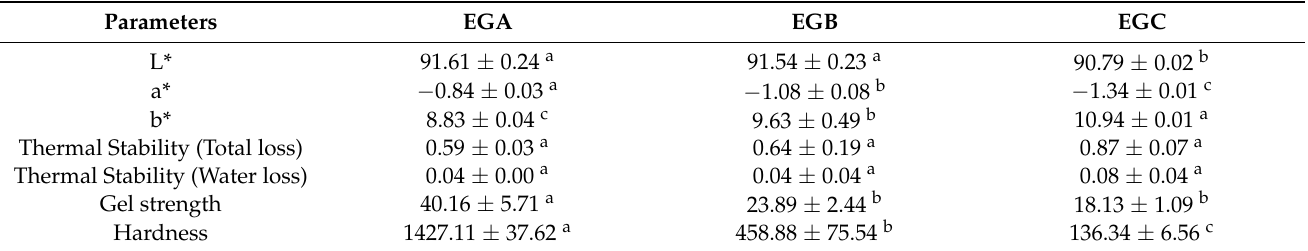
Table 2. Color parameters ((L*) lightness, (a*) redness and (b*) yellowness), thermal stability, gel strength and hardness of EGA, EGB and